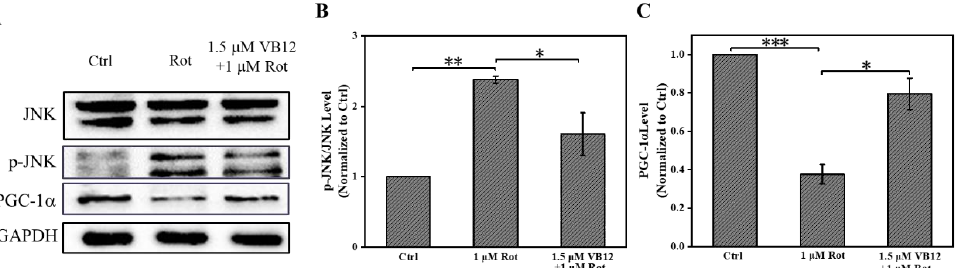
Figure 4. VB12 mediates oxidative stress-related proteins. ( A ) Relative protein levels of JNK and PGC-1 α as shown in the Western blot. ( B ) Quantification of the relative protein level of p-JNK. ( C ) Quantification of the relative protein level of PGC-1 α . Data are the mean ± SEM, n = 3. * p < 0.05, ** p < 0.01, *** p < 0.001.